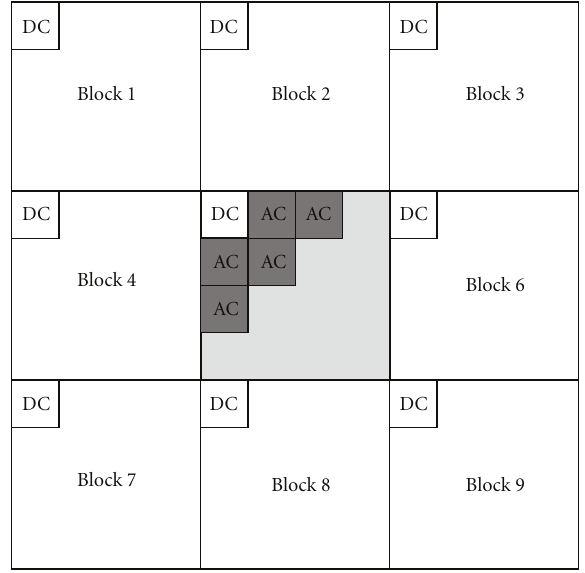
Figure 6: The position of five AC components in the central block that estimated using nine DC components of 3 × 3